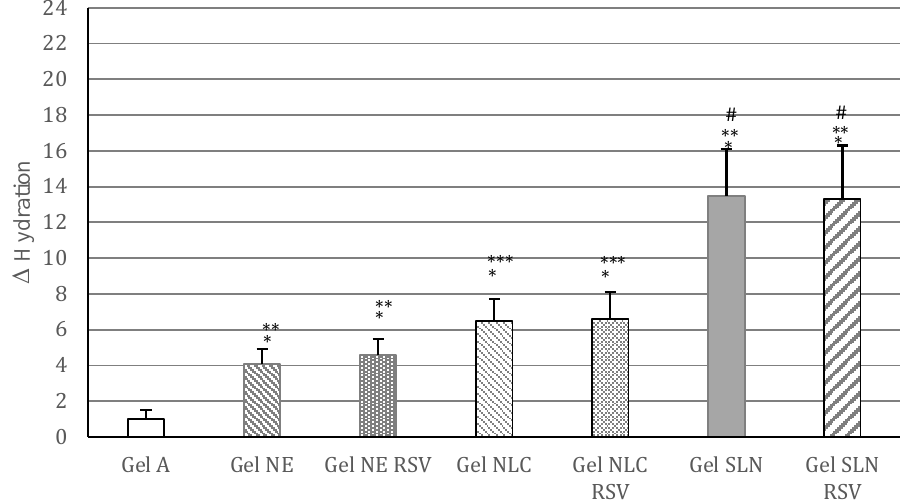
Figure 5. Difference of skin hydration values ( ∆ hydration) recorded after one-week in vivo topical treatment with the gels under investigation ( n = 12). Statistical analysis for the comparison: * p < 0.05 vs. gel A (control); ** p < 0.05 vs. all other gels; *** p < 0.05 vs. all other gels; # p < 0.05 vs. all other gels; p > 0.05 for the comparisons: gel NE vs. gel NE RSV, gel NLC vs. gel NLC RSV, gel SLN vs. gel SLN RSV.